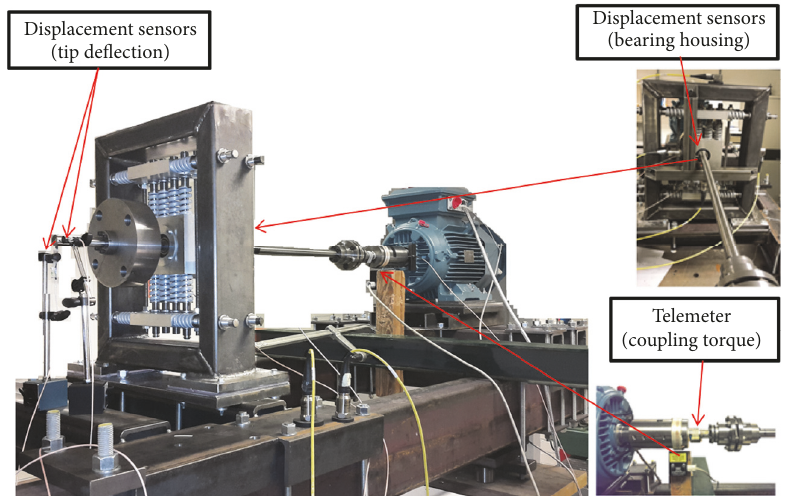
Figure 2: The test rig with sensors